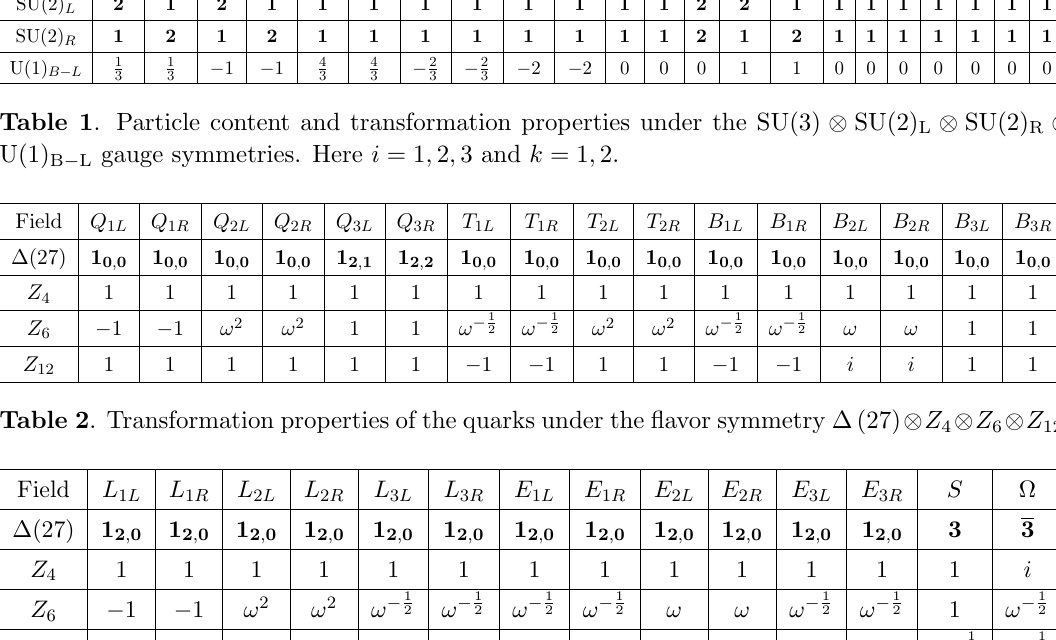
Table 3 . Transformation properties of the leptons under the (cid:13)avor symmetry (cid:1) (27) Field